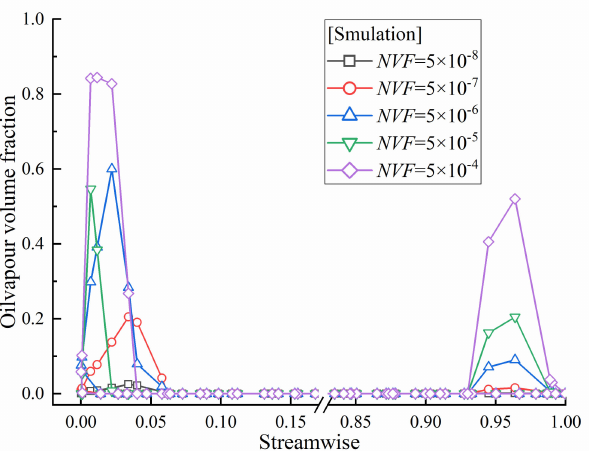
Figure 13. Oil vapor volume fraction on stator blade at stall under various nuclei volume